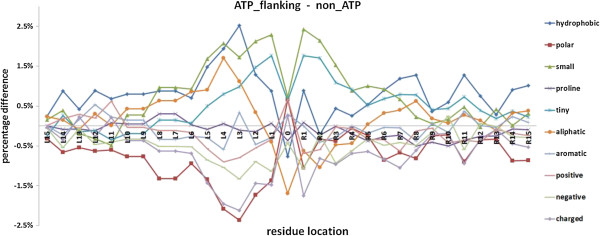
Differences in physicochemical properties between AIRs and non-AIRs. The values at position 0 on the horizontal axis mean the values for the AIRs, L means the left flanking side and R means the right flanking side.